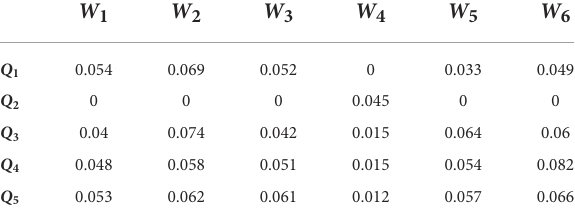
Table 9 of all attributes (see Table